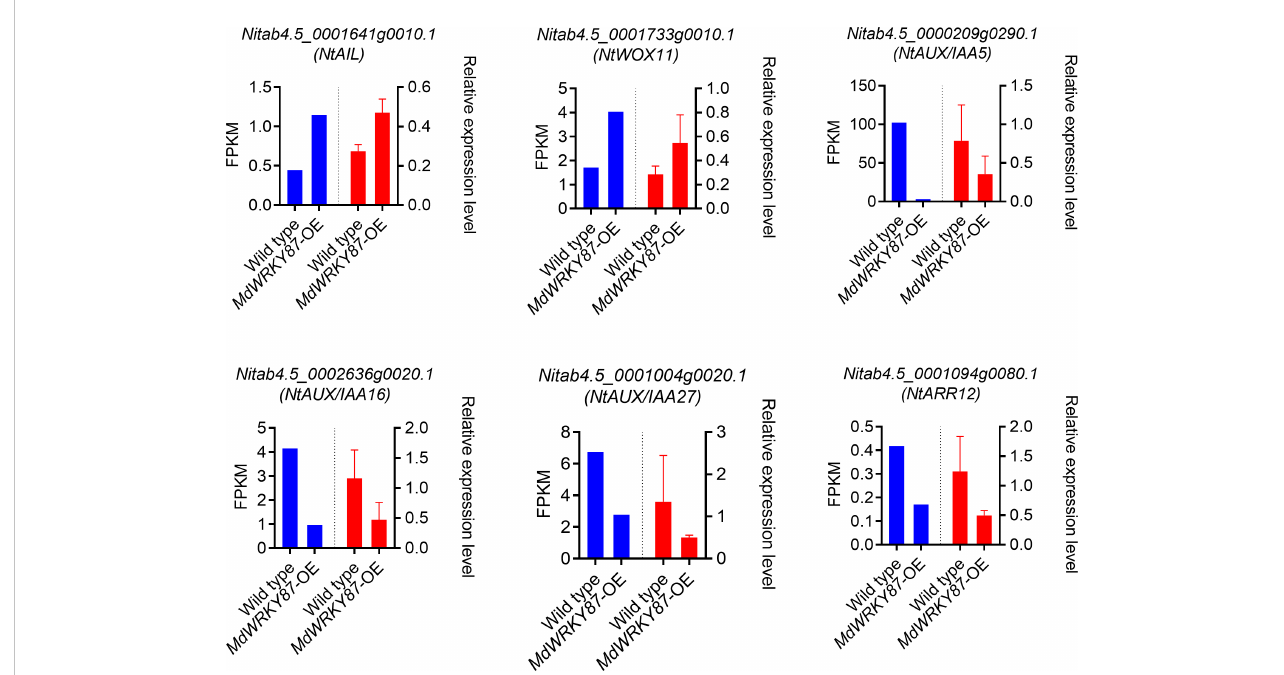
FIGURE 7 qRT-PCR validation of DEGs in RNA-seq data. Six genes were selected from RNA-seq differentially expressed genes (DEGs) to be validated by qRT-PCR. The data were reported as the means ± SE of three biological replicates. A comparison between the gene expression ratios obtained from RNA-seq data and